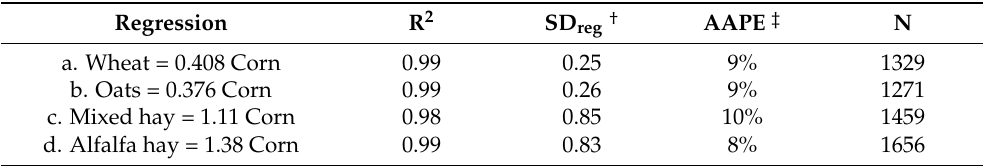
Table 10. Small grain and hay yields on soils relative to corn yield based on soil-survey-reported expected yields. Intercepts were significant ( p < 0.05) but when removed the SDreg change was small and the AAPE increased by only one percentage point on